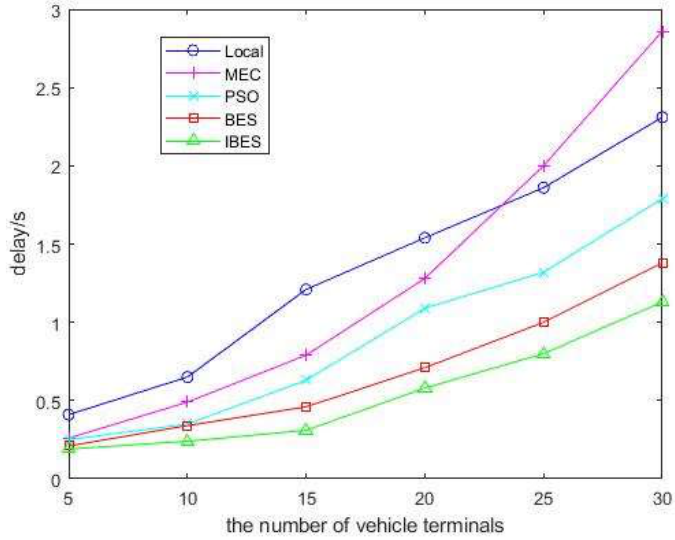
Figure 2. Comparison of system delay under the different number of vehicle terminals.